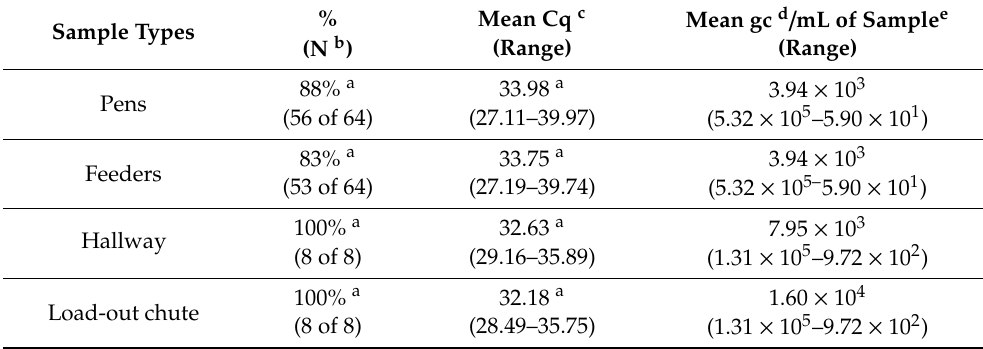
Table 4. Aggregated PoAstV3 detection and RT-qPCR mean Cq and Cq range by environmental sample type over